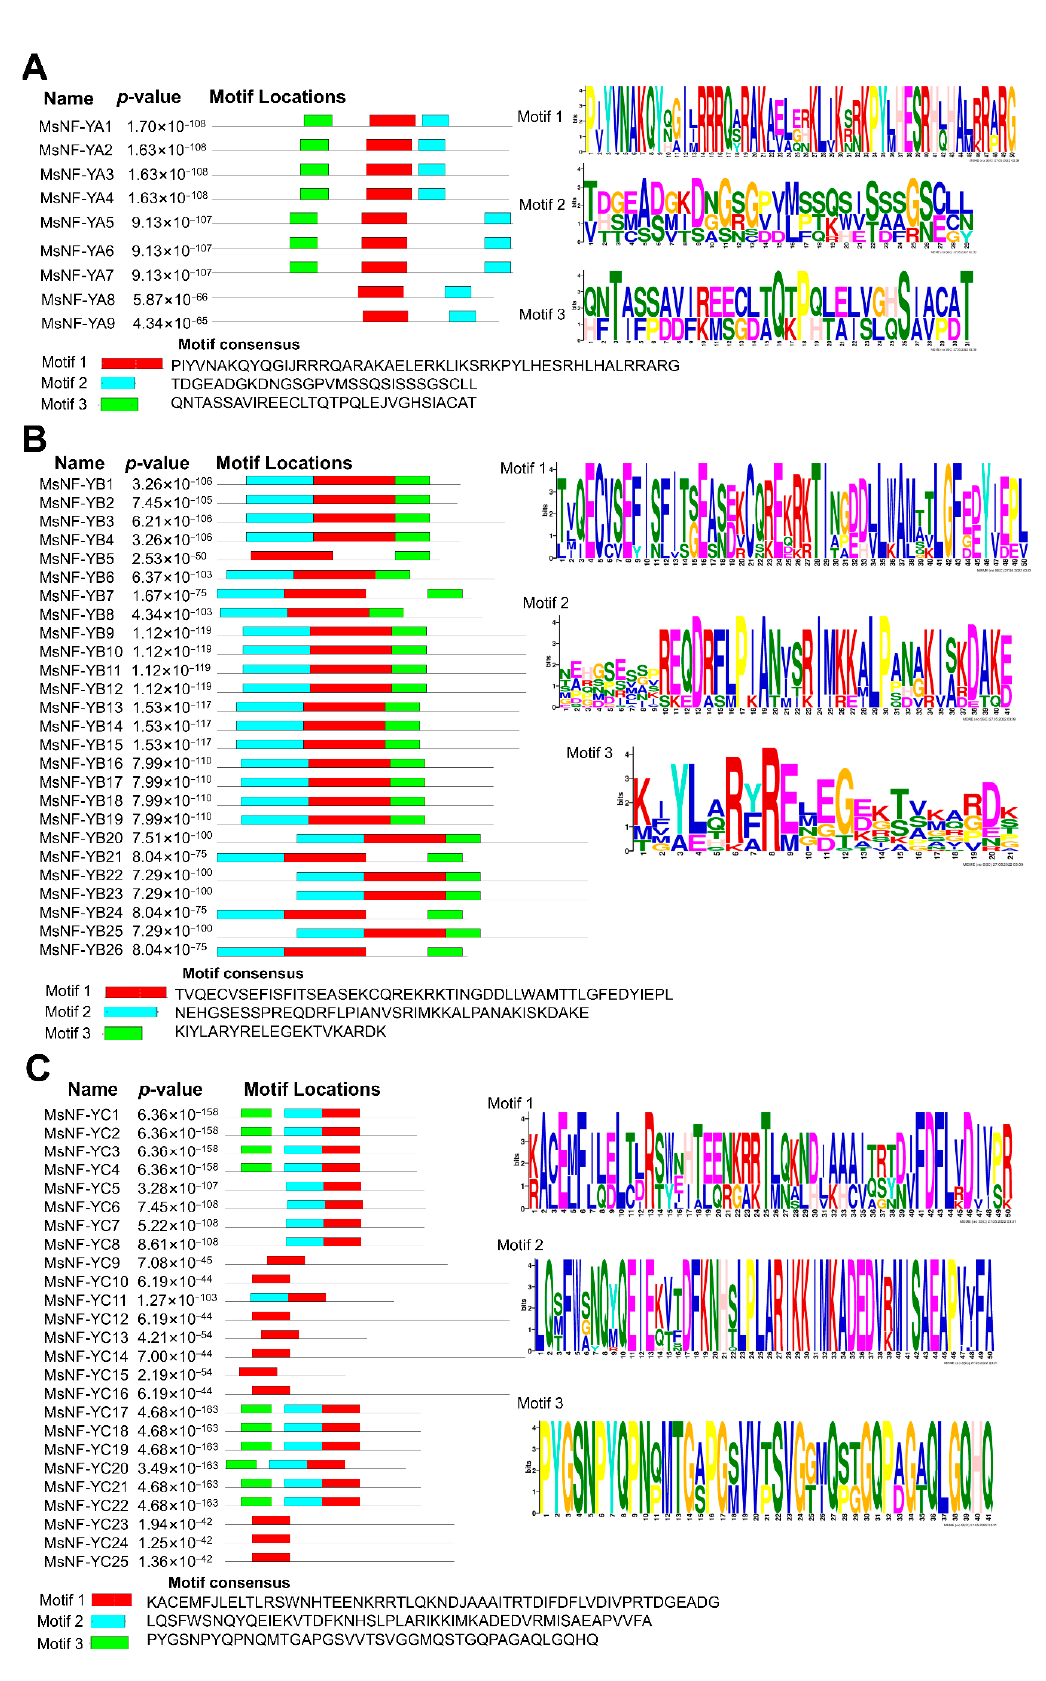
Figure 1. Motif analysis of MsNF-Y proteins. ( A ) MsNF-YA proteins; ( B ) MsNF-YB proteins; ( C ) MsNF-YC